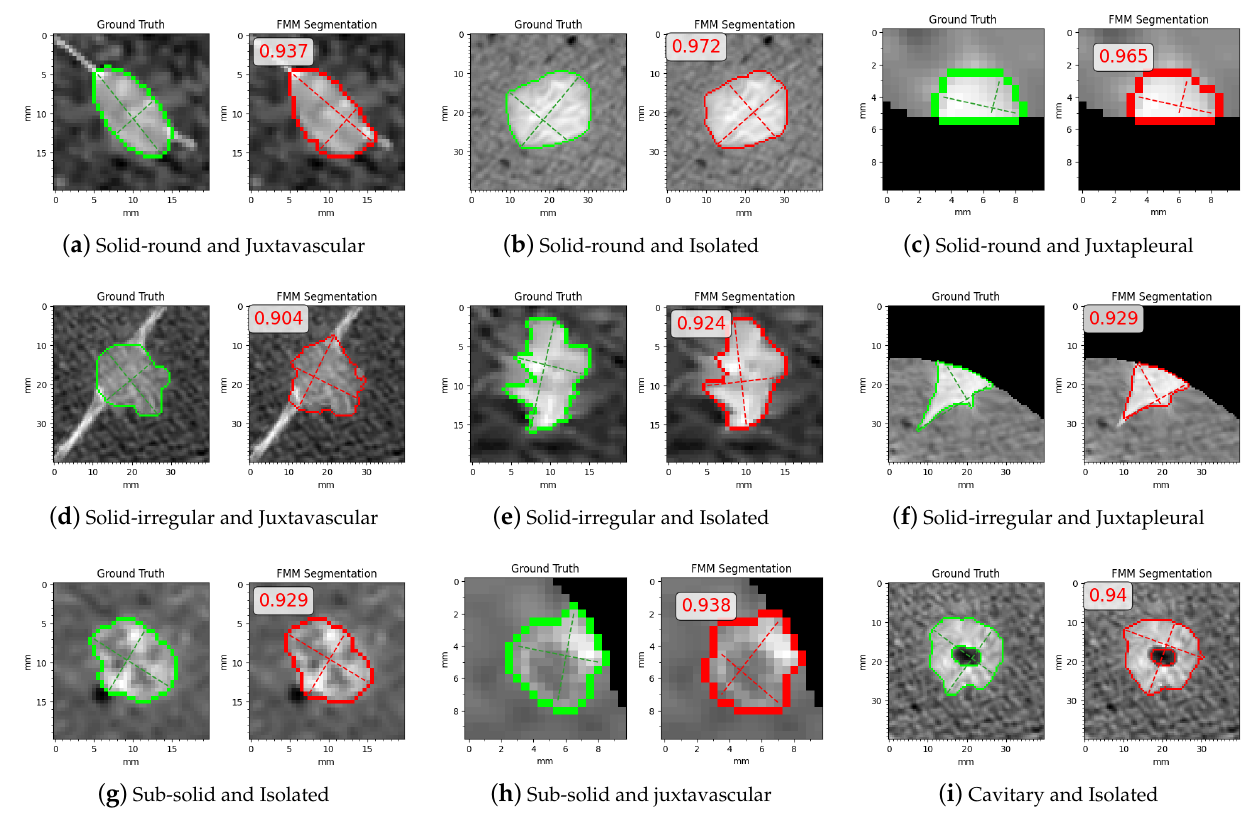
Figure 17. Examples with high Dice